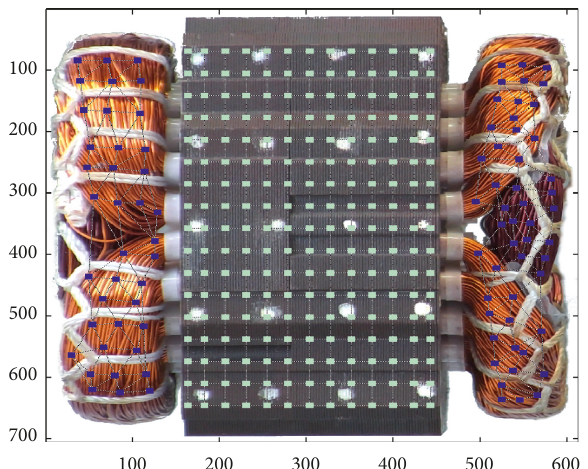
Figure 8: Experimental mesh used in unidirectional modal analysis of stator, including winding.